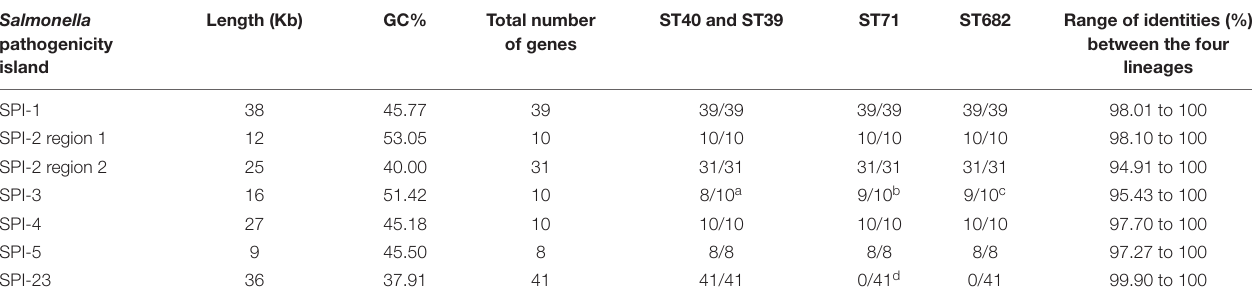
TABLE 1 | Length, genes, and GC content of the main SPIs for Salmonella .